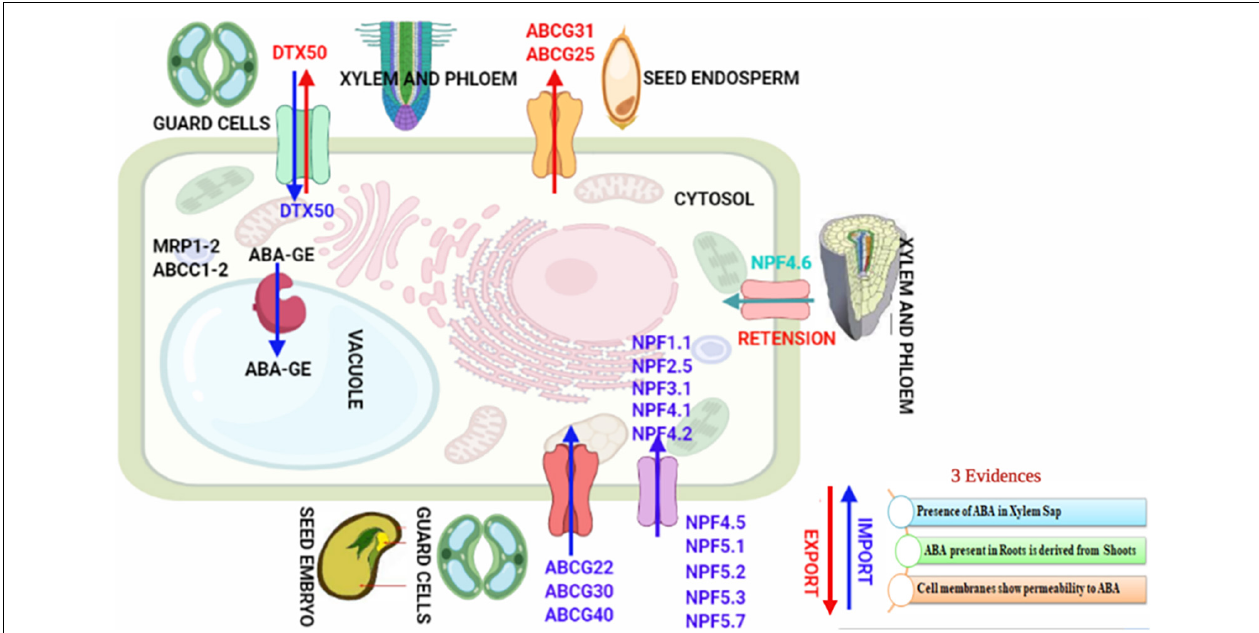
FIGURE 2 | Transporter proteins of